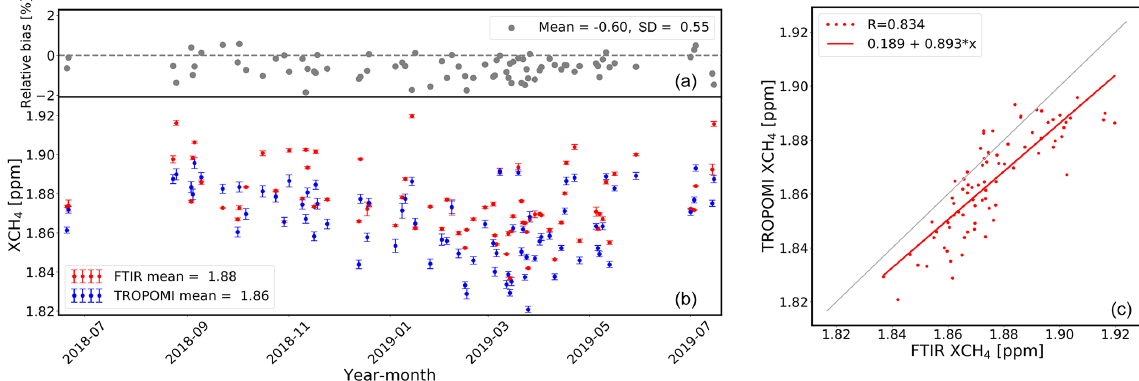
Figure 14. (a, b) Time series of daily mean co-located TROPOMI and ground-based FTIR XCH 4 data at Xianghe (b) and the relative bias between them (a) . The error bars are the relative SDs of co-located TROPOMI and FTIR XCH 4 data. (c) Correlation plot between co-located daily mean XCH 4 data from TROPOMI and the FTIR instrument at Xianghe.